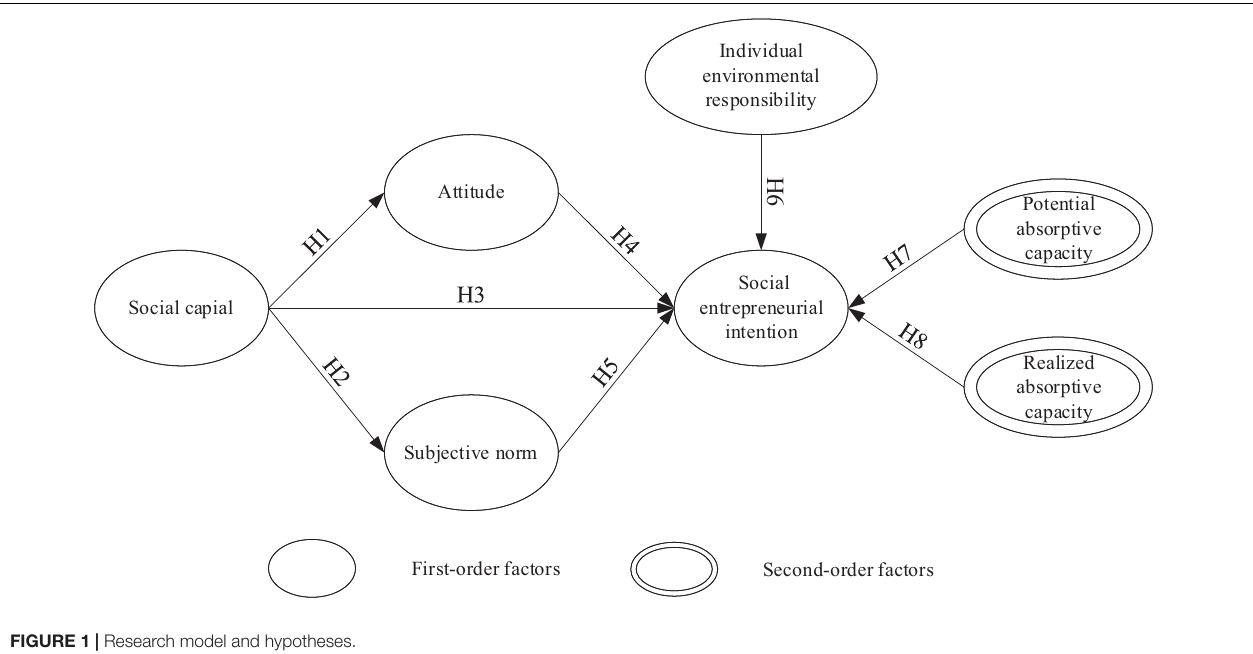
FIGURE 1 | Research model and